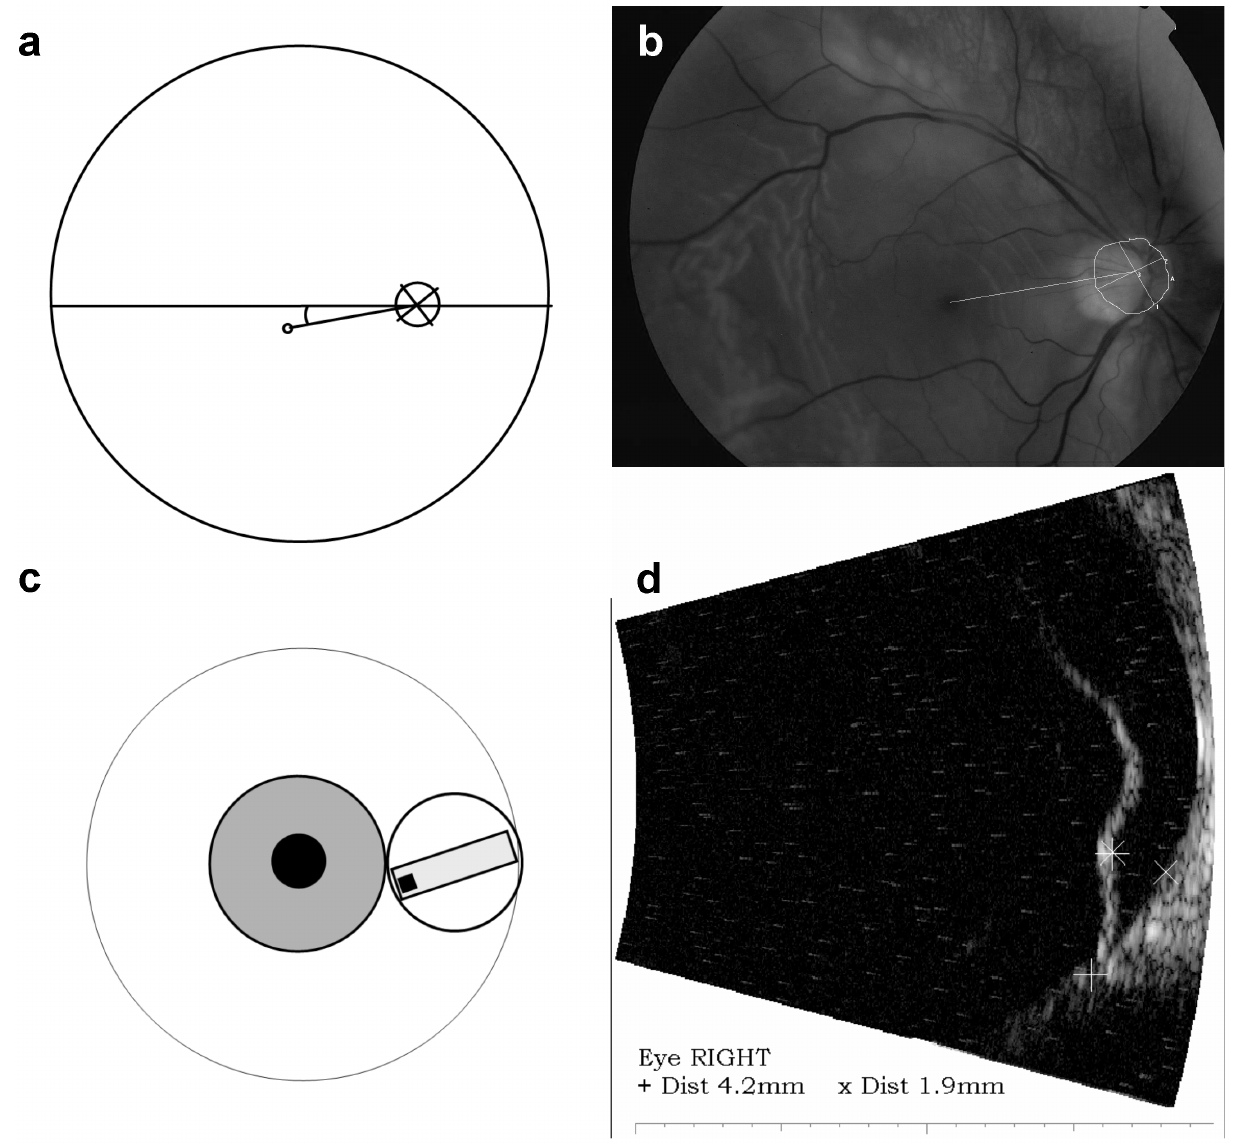
Figure 1. Method to measure the height of the foveal detachment by ultrasonography. a . Schematic drawing of the measurement of the distance between the center of the optic nerve head and fovea, and assessment of the angle between their connecting line with the horizon. b . Drawing of the measurement of the distance between the center of the optic nerve head (determined by drawing a circle along the outer edge of the optic disc, excluding the area of peripapillary atrophy) and fovea, and assessment of the angle between their connecting line with the horizon made on a fundus photograph. c . Schematic position of the ultrasound probe at the correct angle between the horizon and the connecting line between the center of the optic nerve head and the fovea based on the measurement made on the fundus photograph d . Measurement of the height of the retinal detachment by ultrasonography at the measured distance between the center of the optic nerve head and the fovea, as obtained by measuring this distance on the fundus